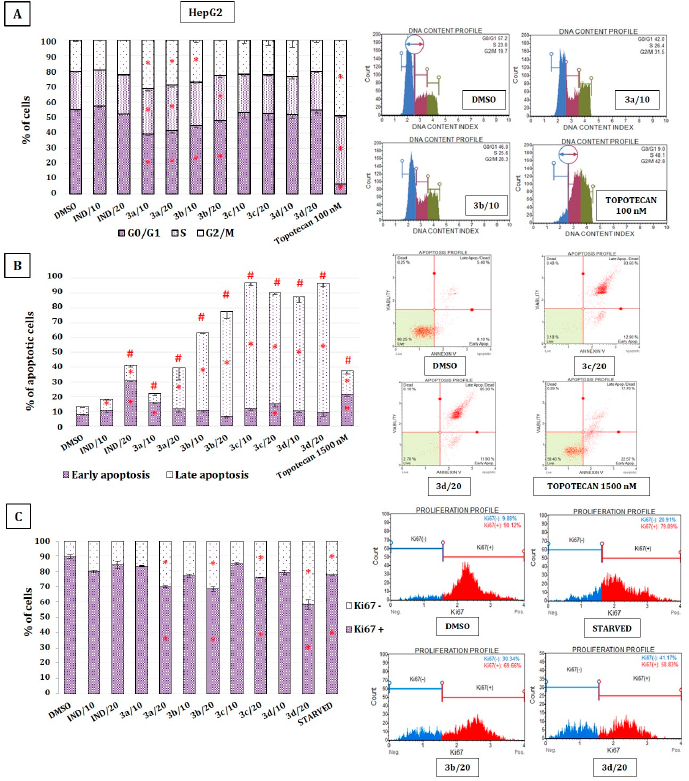
Figure 8. The effect of IND and OAO–IND derivatives ( 3a, 3b, 3c, and 3d ) on the cell cycle distribution ( panel A ), apop- tosis induction ( panel B ), and proliferation level ( panel C ) in HepG2 cells. Panel A : Graphs represent the percentage of cells in the G1/G0, S, and G2/M phases measured by the flow cytometry after propidium iodide staining. Topotecan was used as a positive control. Representative plots are presented. Panel B : Graphs represent the percentage of cells in the early and late stages of the apoptosis assessed by the flow cytometry measurements based on the signal from annexin V bound to phosphatidylserine externalized in apoptotic cells. A dead cell marker, 7-AAD, was also included. Topotecan was used as a reference for pro-apoptotic activity. Representative plots are presented. Panel C : graphs represent the percentage of proliferating (Ki67(+)) and nonproliferating (Ki67( − )) cells measured by the flow cytometry. Starved cells (cultured in FBS-free medium) were used as a reference to antiproliferative conditions. Representative plots are presented. For all panels, mean values ± SEM from three independent experiments are shown. Asterisks (*) denote statistically significant changes from DMSO (control)-treated cells, and for panel B denote statistically significant changes in the percentage of either early or late apoptotic cells, while hashes (#) denote statistically significant changes in the percentage of total apoptotic cells, p <